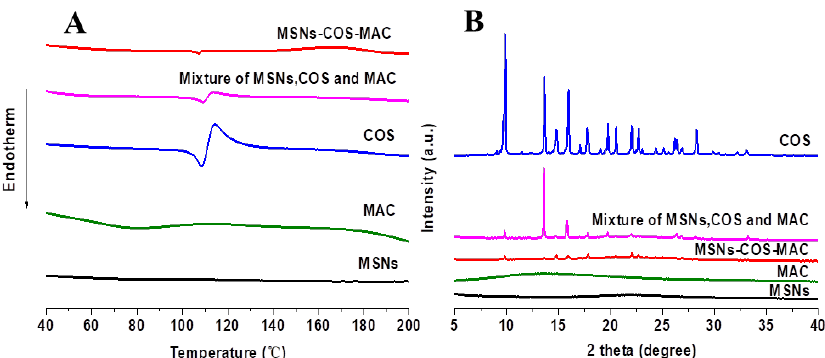
Figure 3. DSC graphs ( A ) and XRD patterns ( B ) of MSNs, MAC, COS, the physical mixture and MSNs-COS-MAC.